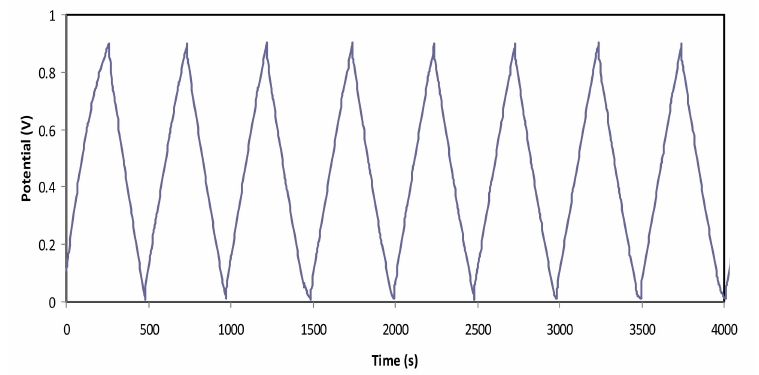
Figure 9. Charge-discharge profile for the fabricated EDLC device.